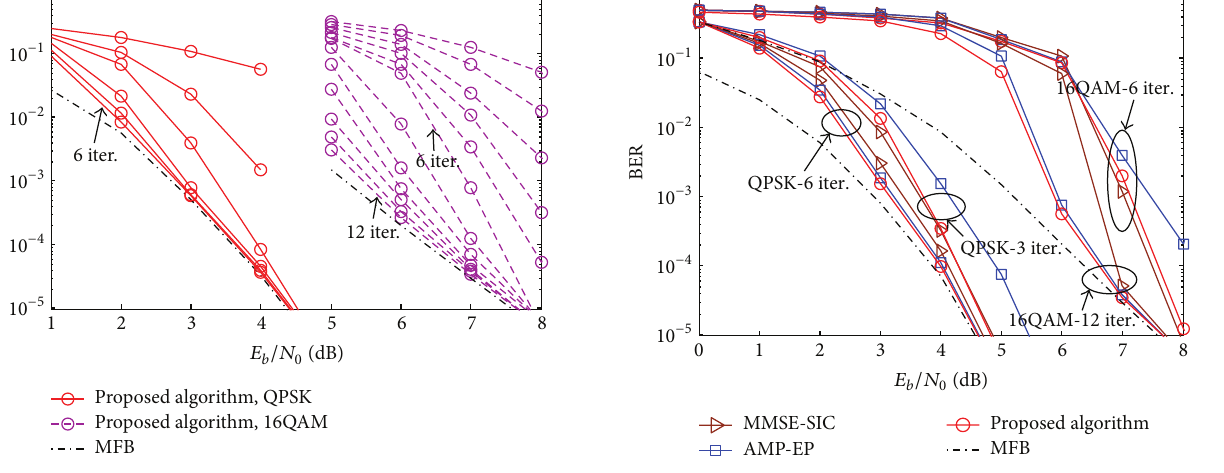
Figure 9: BER performance for different detection algorithms in a 4 × 4 MIMO system, with QPSK and 16QAM modulation, 16-tap Rayleigh channel with equal tap